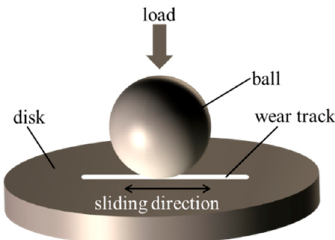
Figure 3. Schematic of the reciprocating test.